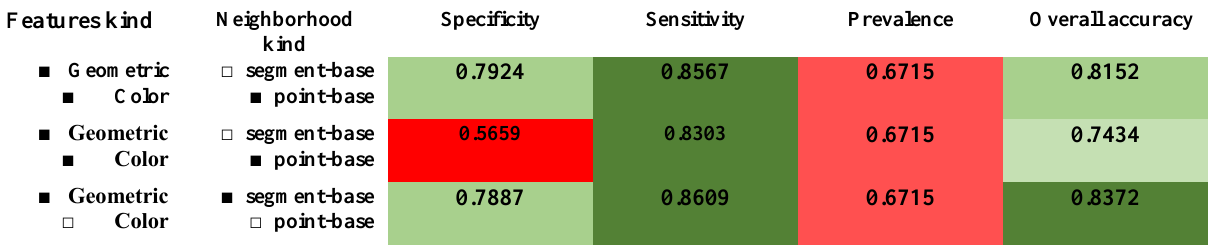
Table 2. Evaluation of classification performance (in %)